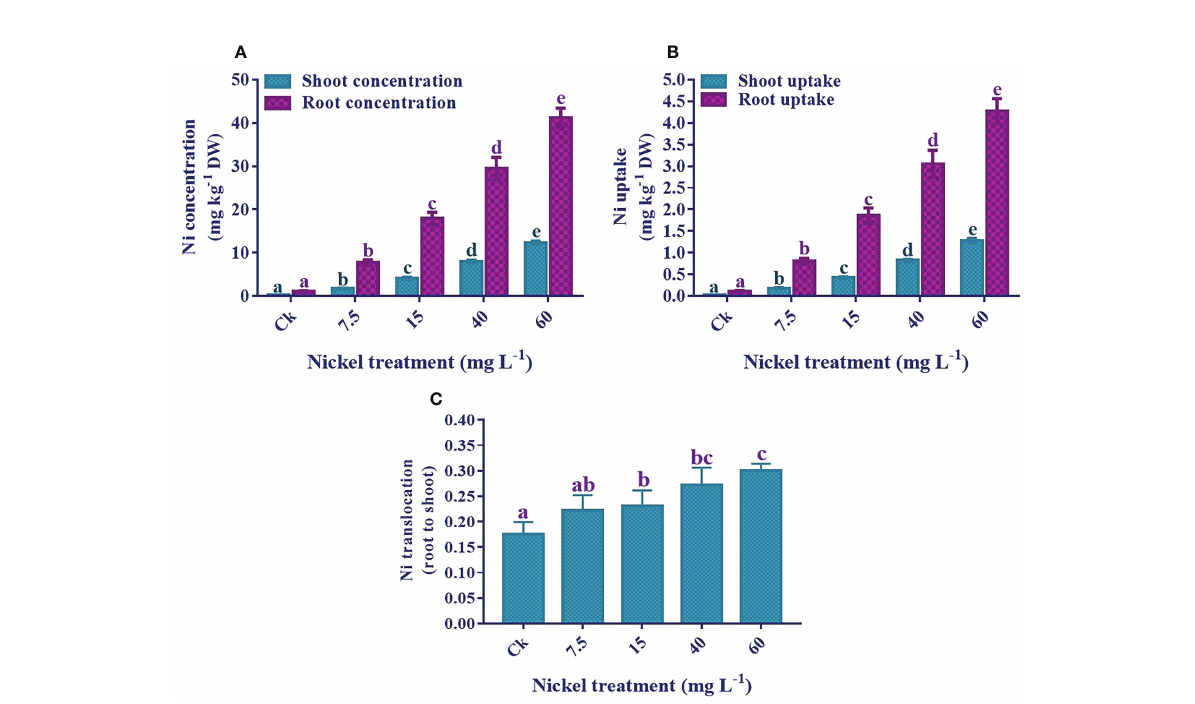
FIGURE 10 Effect of different Ni treatments on the concentrations, uptake, and translocation (root to shoot) of Ni in the sweetpotato. (A) Ni concentration in shoots and roots, (B) Ni uptake, and (C) Ni translocation. According to the Duncan test, different letters indicate a signi fi cant difference ( p < 0.05) among the fi ve treatments. The error bars represent the mean ±